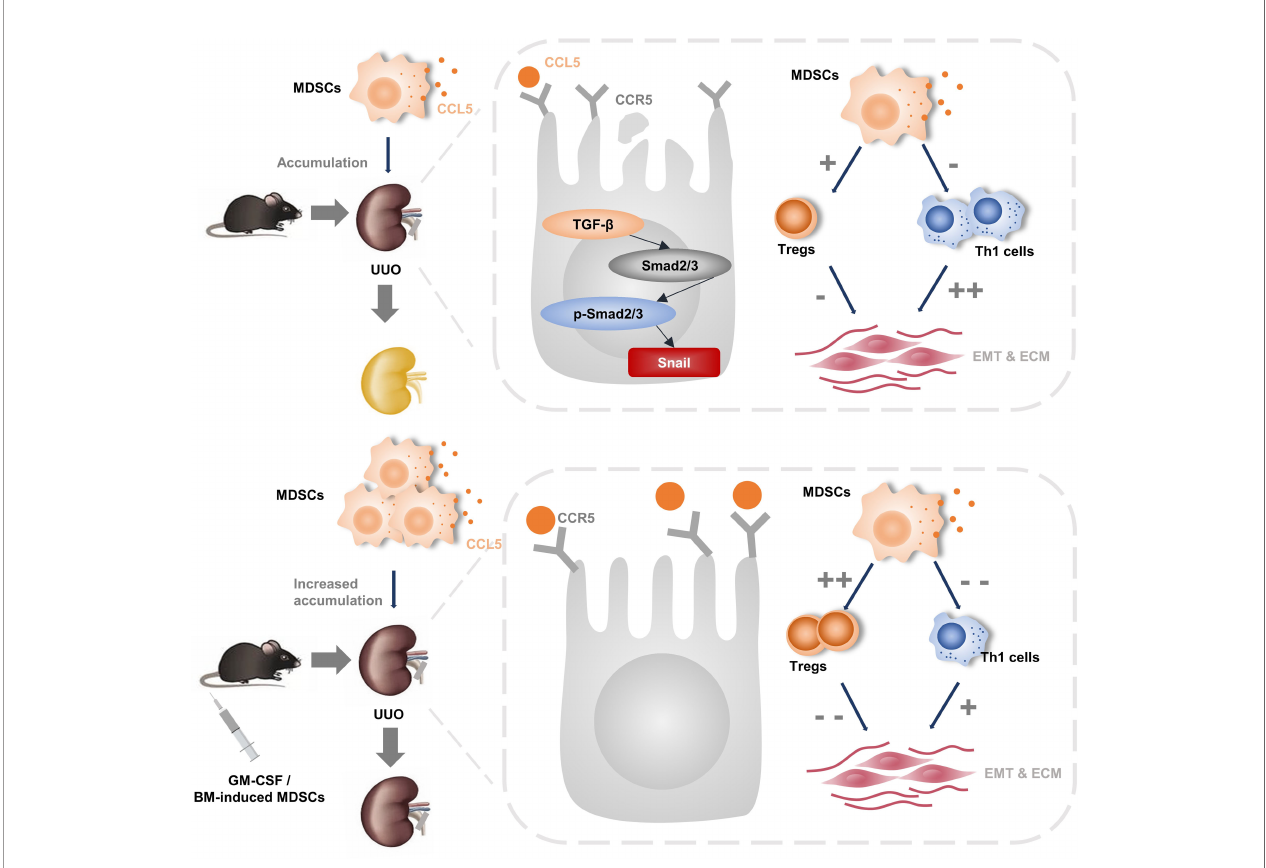
FIGURE 7 | The pictorial summary of induced MDSCs on renal fi brosis. In vitro- and in vivo- induced MDSCs increased their in fi ltration to injury by promoting CCL5- CCR5 interaction. In addition, they alleviate renal fi brosis to a similar extend by inhibiting TGF- b 1/Smad/Snail signaling pathway and rebalance